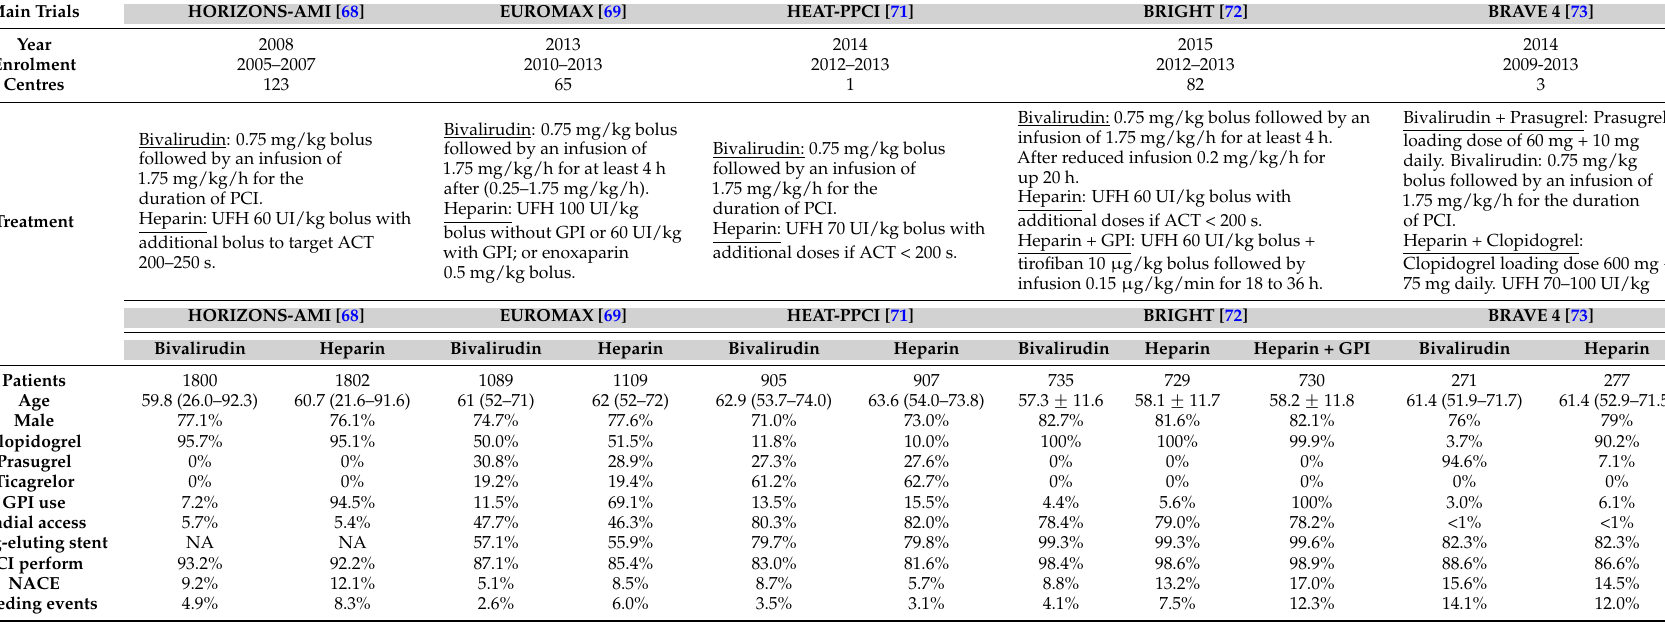
Table 1. Randomised clinical trials of bivalirudin in patients with